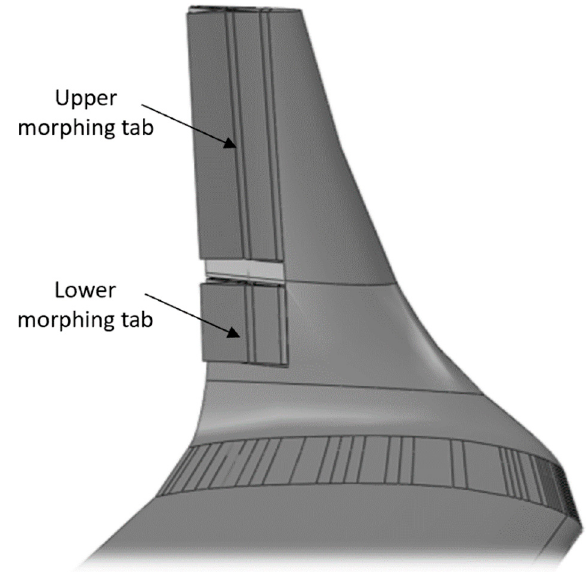
Figure 2. Morphing winglet concept with upper and lower control surfaces [18].